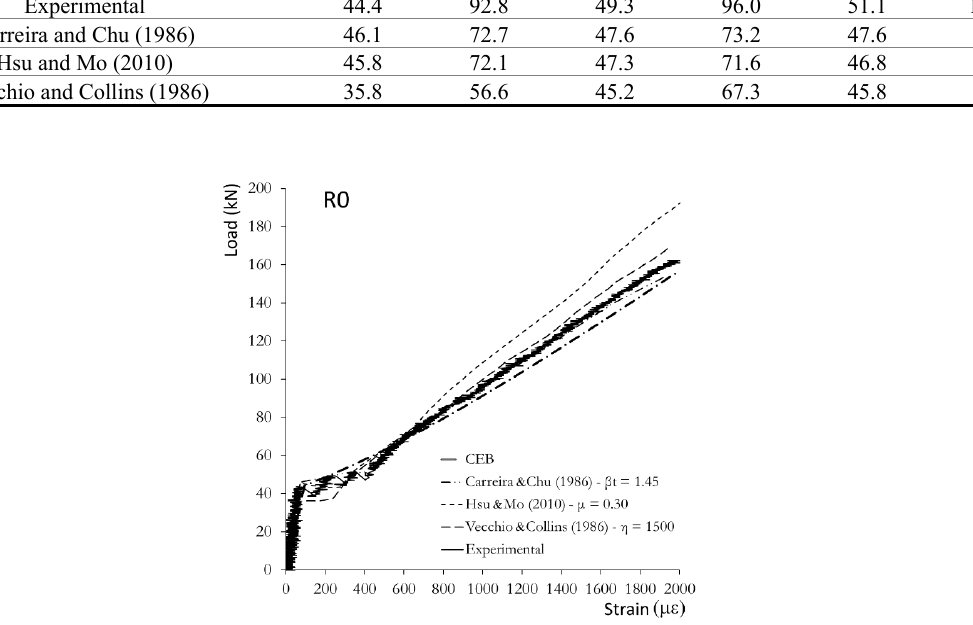
Figure 11. Comparison between numerical models, analytical model and experimental result for the tension stiffening element with conventional concrete